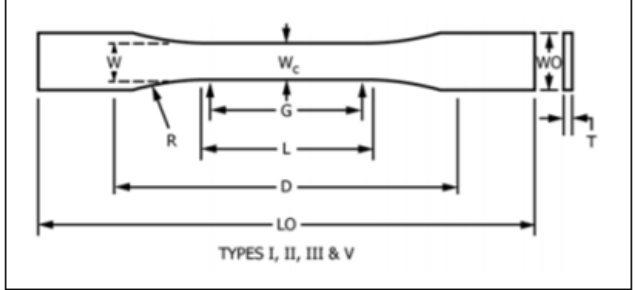
Figure 2. Diagram of ASTM standard tensile specimen [15].